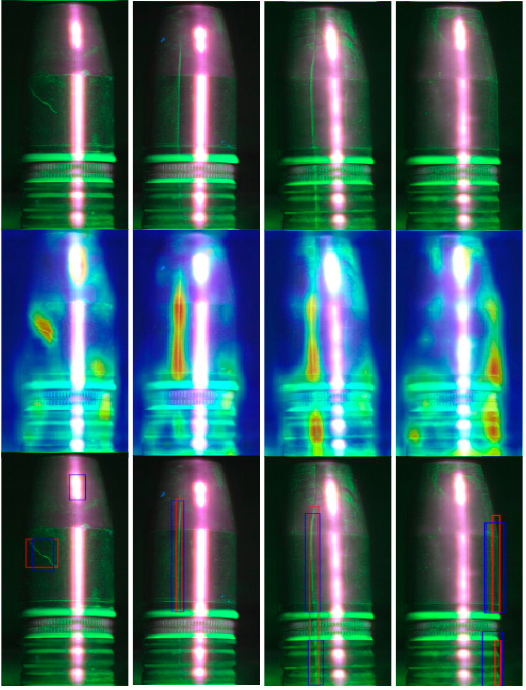
Figure 11. Localization results of the proposed method on the fluorescent magnetic powder surface defect dataset. From top to bottom are the original image, the combination of the original image and the heat map, and the location results of these defects. The Ground-Truth of the defect is marked with the red bounding boxes, and the localization result of the proposed method is marked with the blue bounding boxes.